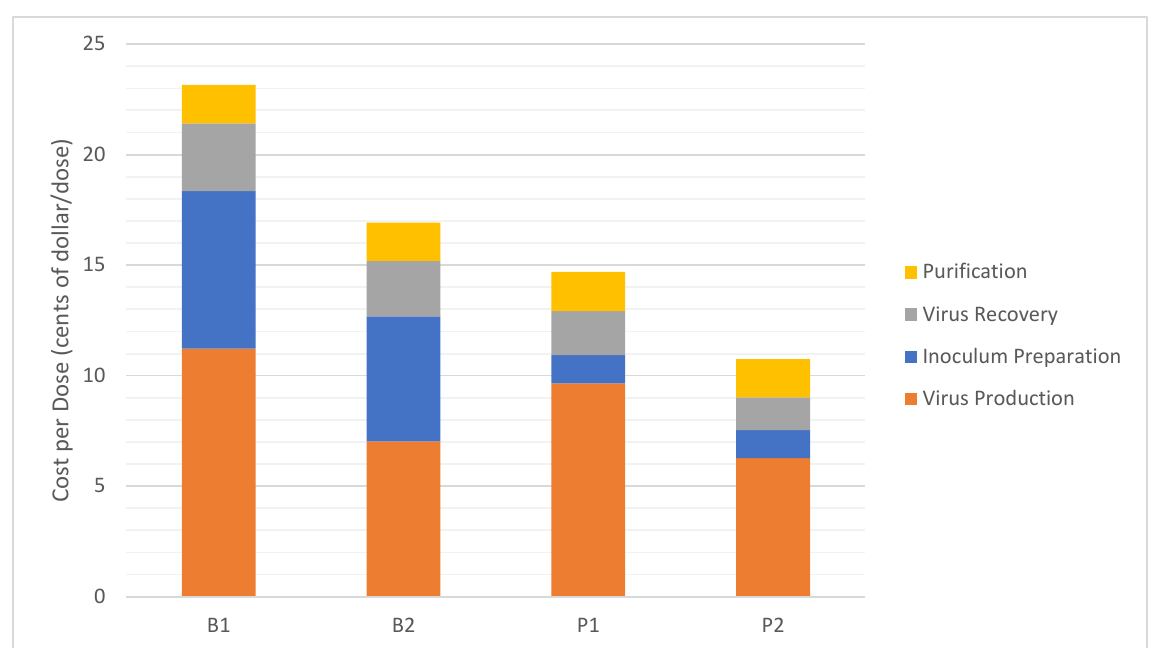
Figure 4. Breakdown of the total operating cost (in terms of cost per dose) by process section. One vaccine dose contains 5 × 10 10 VP with 10% overfill.